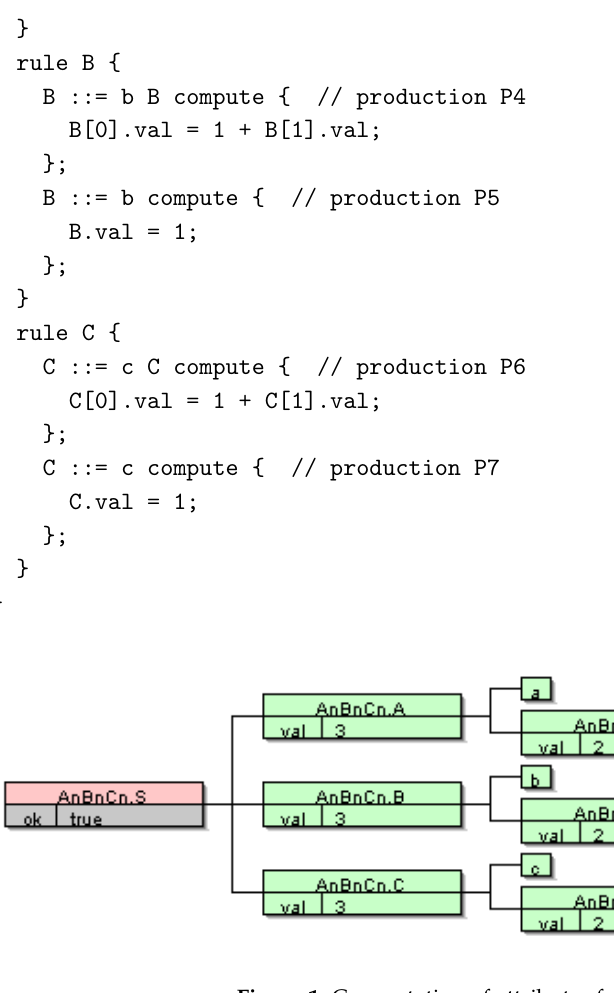
Figure 1. Computation of attributes for sentence “aaabbbccc”.